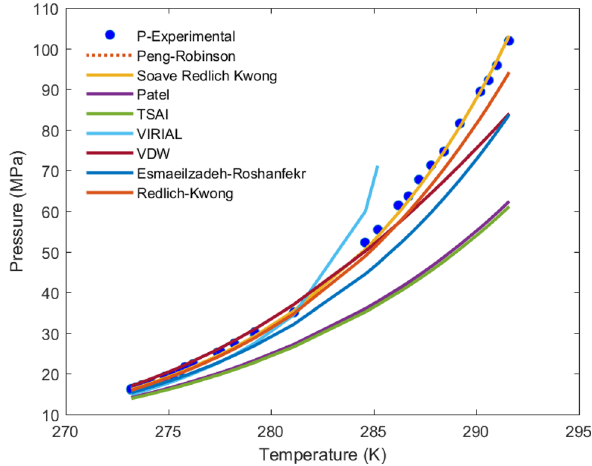
Fig. 12 Predicted pressure versus experimental plot for L phase region, AAD %, [Min/Max] of [1.7/26.2]